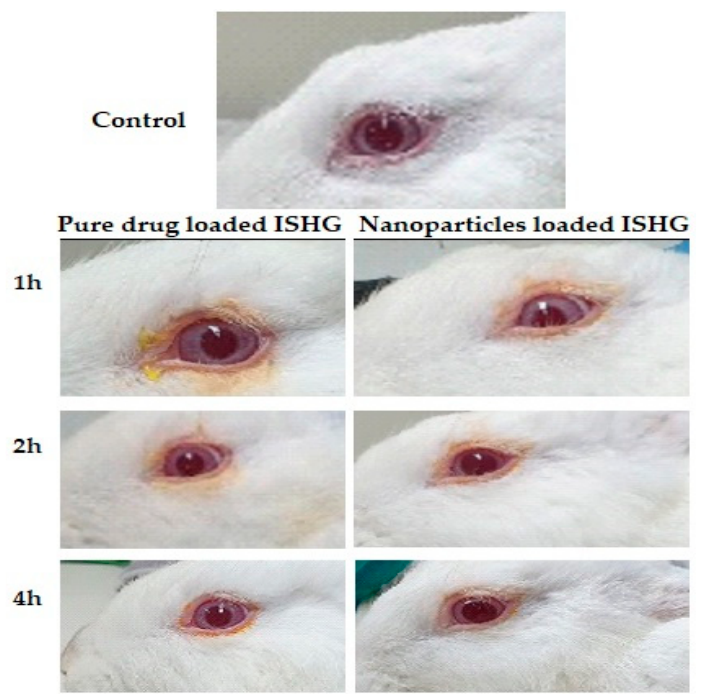
Figure 8. Macroscopic examination of the eye treated with the prepared ophthalmic formulations.